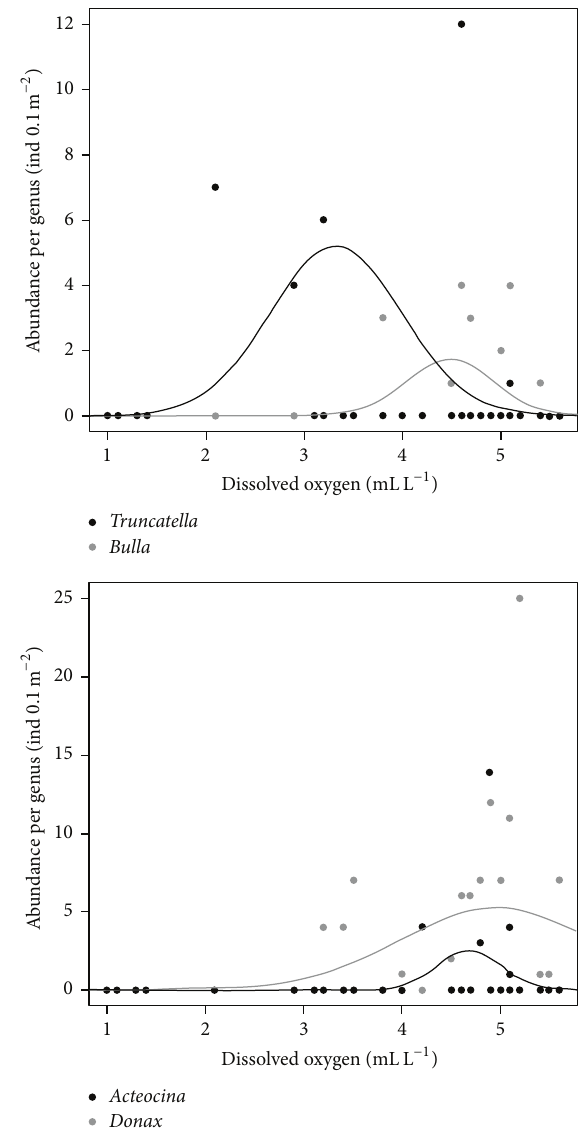
Figure 4: Negative binomial generalized linear models (lines) fitted for mollusk abundance per genus (dots) in relation to oxygen